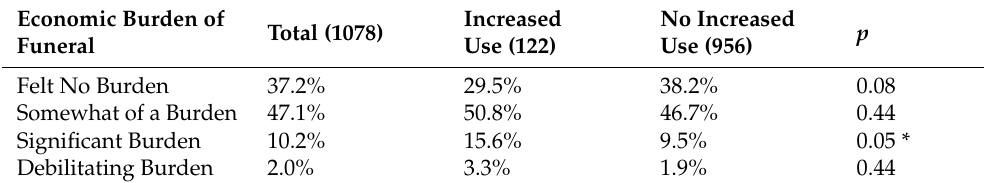
Table 5. Relation of funeral’s economic burden to increased medical/social service